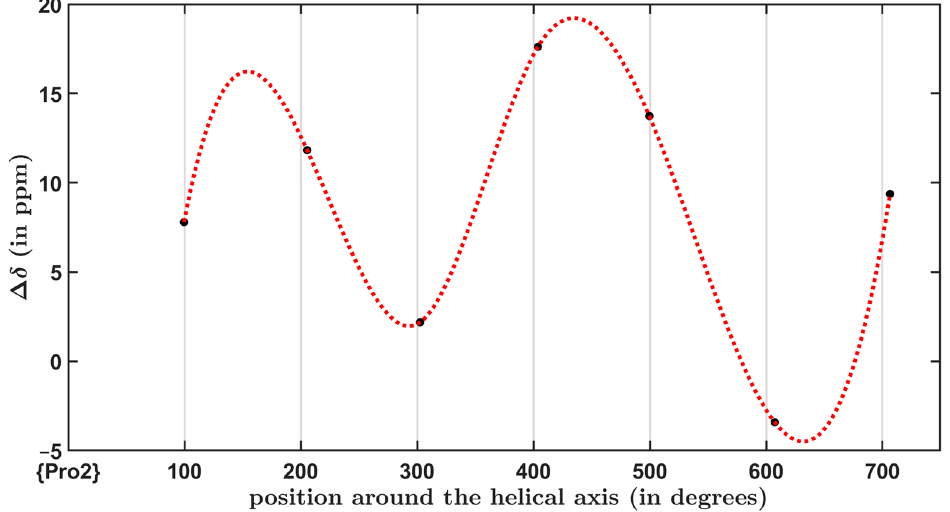
Figure 4. The dependence of the total 13 C chemical shift anisotropy upon the rotation angle in the ALM-18 model. The simulated functional dependence is expressed by Equation (2), while the data- points are described in Section 2.3. datapoints are described in Section